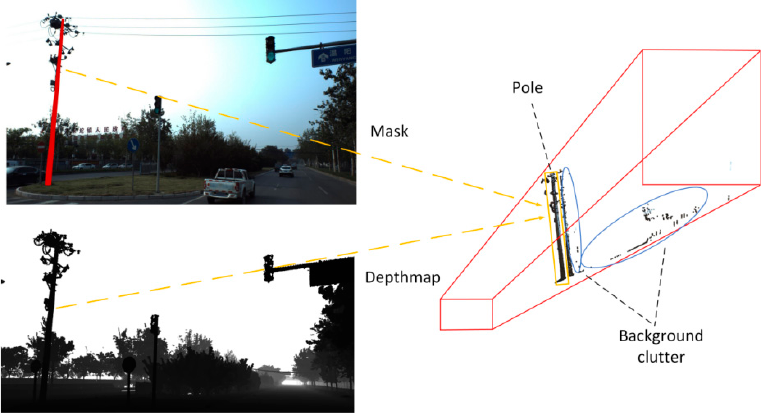
Figure 10. 3D reconstruction results.